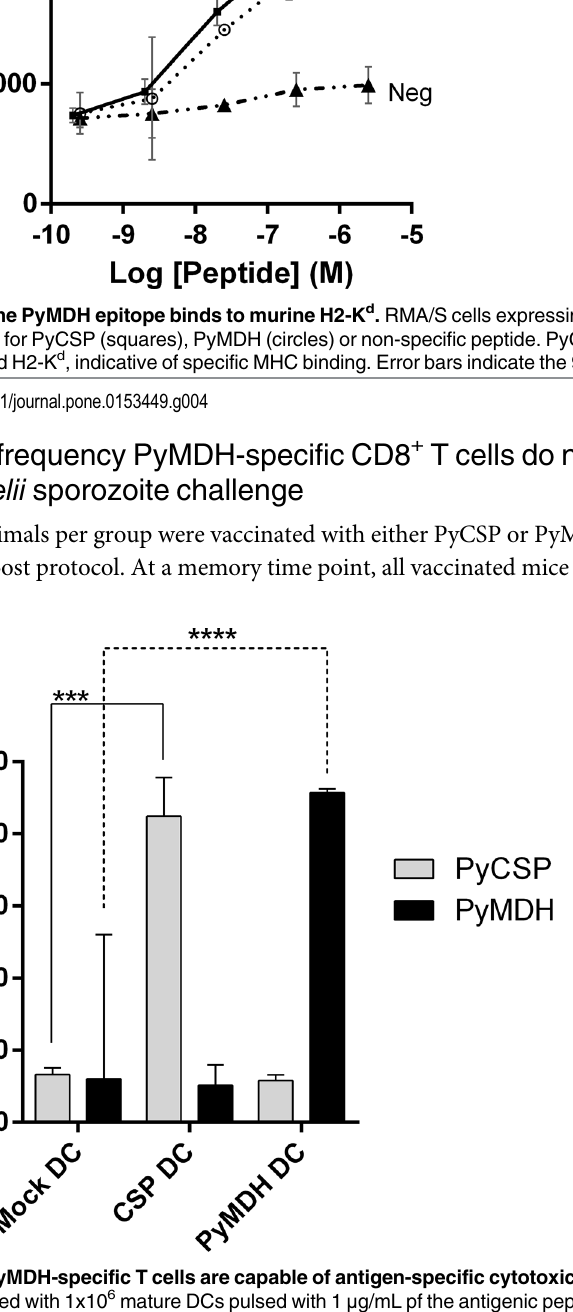
Fig 5. PyMDH-specific T cells are capable of antigen-specific cytotoxic killing. Mice were previously immunized with 1x10 6 mature DCs pulsed with 1 μ g/mL pf the antigenic peptide (PyCSP DC or PyMDH DC). Six days later mice were administered equal numbers of PyCSP peptide-coated CFSE HI and PyMDH-peptide coated CFSE LO target splenocytes; antigen-specific killing was monitored 18 hr later by flow cytometry. Like cytotoxic PyCSP-specific T cells, PyMDH-specific T cells demonstrate a high rate of antigen-specific killing. Bars indicate mean and 95% confidence interval; *** p < 0.001; **** p < 0.0001 (Student ’ s t